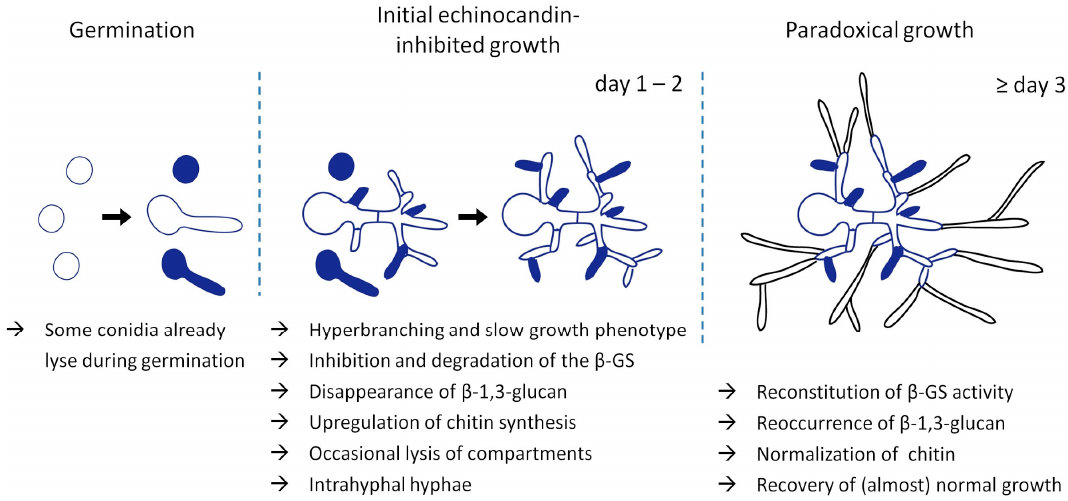
Figure 1. Manifestation of paradoxical growth of A. fumigatus exposed to echinocandins. A limited number of conidia do not survive germination in the presence of echinocandin antifungals. Surviving microcolonies exposed to high echinocandin concentrations show a slow growth phenotype characterized by hyperbranching, occasional lysis of hyphal compartments (colored compartments), translocation of the β -GS to vacuoles, disappearance of cell wall β -1,3-glucan and compensatory increase of cell wall chitin (blue cell walls). Regenerative intrahyphal growth initiated from the septa occurs in some lysed compartments. After approximately 2–3 days, paradoxically growing hyphae emerge from the β -1,3-glucan-depleted and growth-inhibited microcolonies. These paradoxically growing hyphae are characterized by fast growth, normal morphology, renewed localization of the β -GS to the hyphal tips, reconstitution of β -1,3-glucan synthesis, and normalization of the cell wall chitin levels.